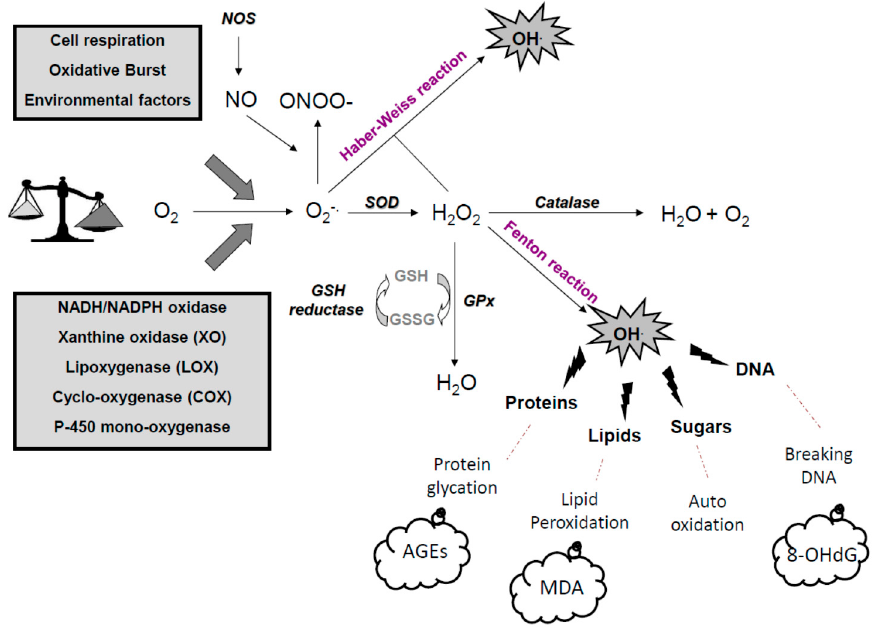
Figure 2. Oxidative defense and complications. AGEs: advanced glycated end-products; COX: cyclooxygenases; H 2 O 2 : hydrogen peroxide; LOX: lipoxygenases; NO: nitric oxide; NOS: NO synthase; NADPH oxydase: nicotinamide adenine dinucleotide oxidase; MDA: malondialdehyde (lipid peroxidation); SOD: superoxyde dismutases; GPx: glutathione peroxydase; GSH gluthathione; O 2. − :superoxide anion; ONOO . − : peroxynitrite; OH. hydroxyl radical; 8-OHdG: 8-hydroxy-2’-deoxyguanosine (DNA damages).